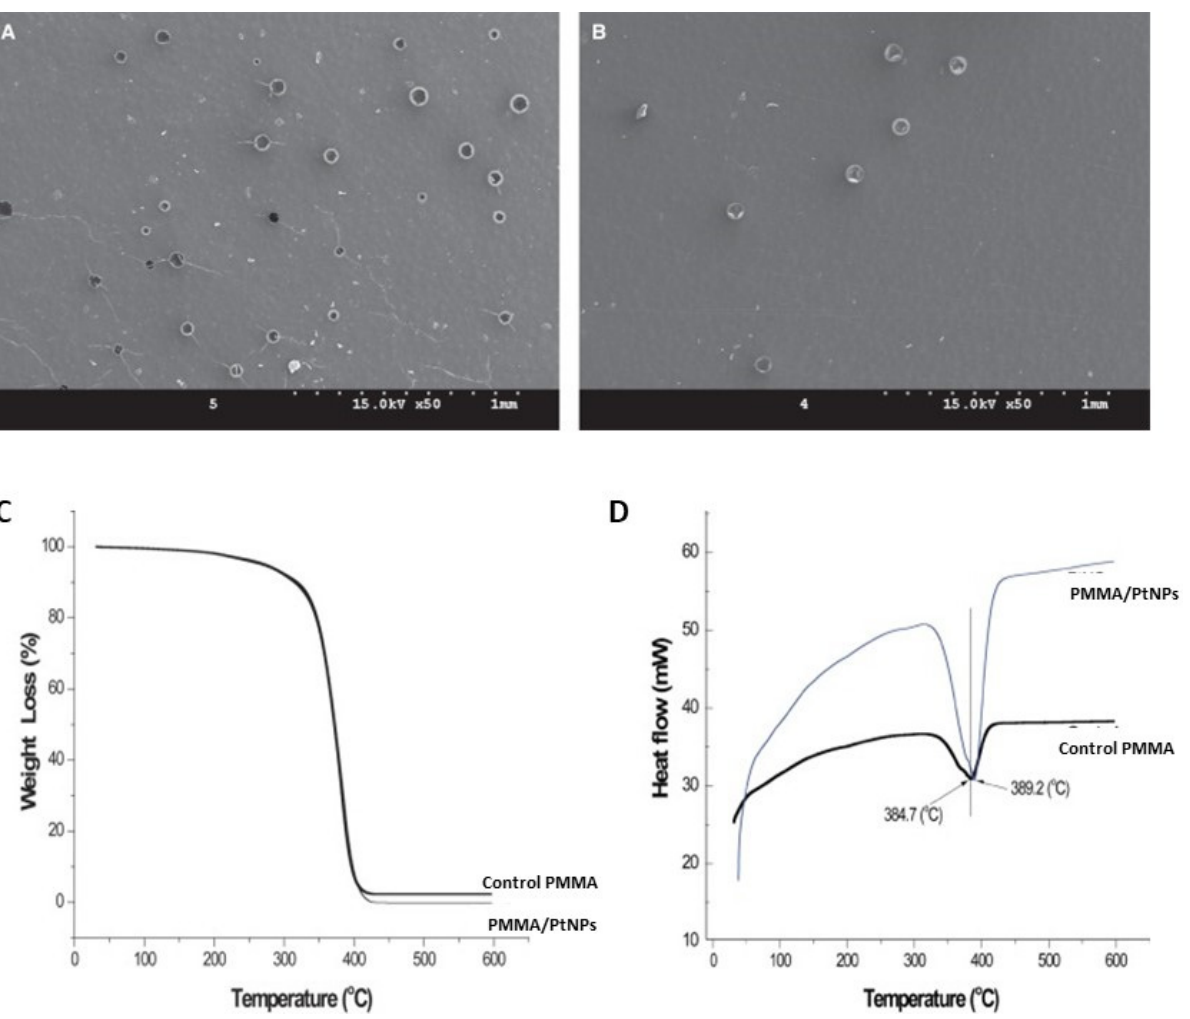
Figure 4. SEM image of control PMMA ( A ) and PMMA/PtNP nanocomposite (200 mg/L) ( B ). TGA curves of PMMA and PMMA/PtNP ( C ), showing overlapping curves in the range 350–400 °C. DSC thermograms of PMMA and PMMA/PtNP ( D ), ranging from 30 °C to 600 °C, the melting point of the nanocomposite (389.2 °C) is slightly higher than that of the control (384.7 °C). Reprinted from ref. [96], copyright 2019, Elsevier.